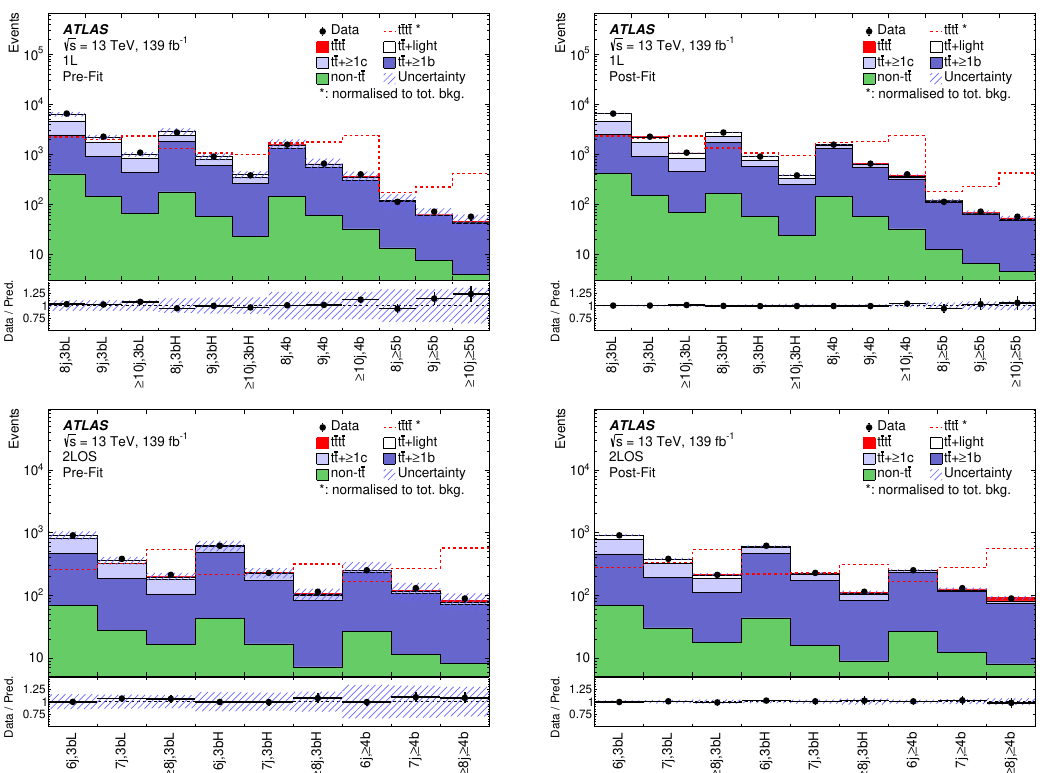
Figure 6 . Comparison of predicted and observed event yields in each control and signal region in the 1L channel (top) and in the 2LOS channel (bottom) before the fit (left) and after the fit (right). The t ¯ t +jets background is corrected at the pre-fit level using data. The band includes the total pre- or post-fit uncertainties. The dashed red line shows the signal distribution normalised to the total back- ground yield. The ratio of the data to the total pre- or post-fit prediction is shown in the lower panel. After excluding the uncertainty in the SM t ¯ tt ¯ t cross section, the t ¯ tt ¯ t production